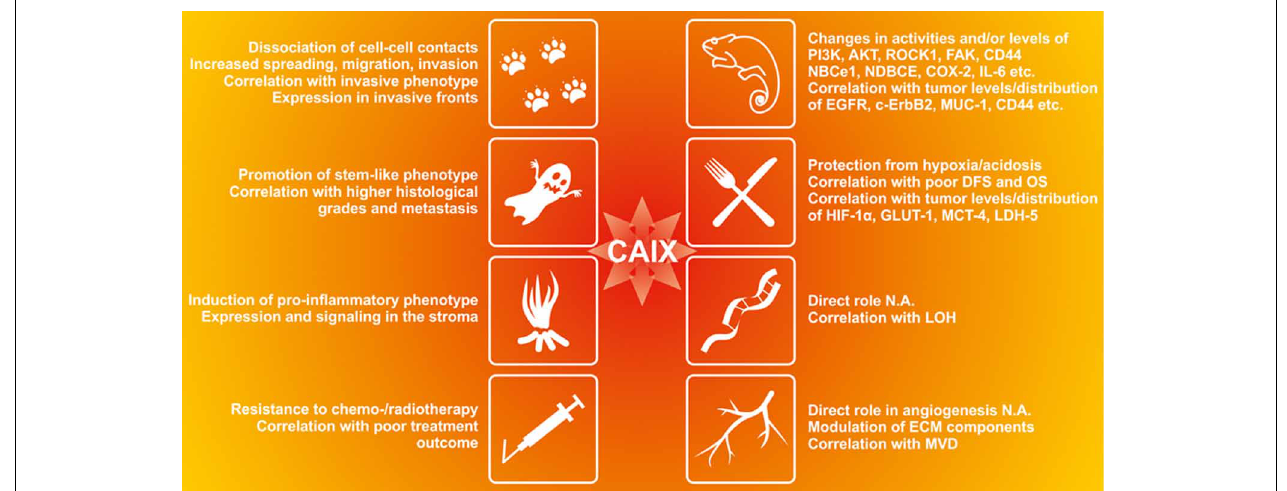
including MMP2, MMP9 and collagen IV (Radvak et al., 2013) and its expression correlates with loss of heterozygozity (LOH) in head and neck